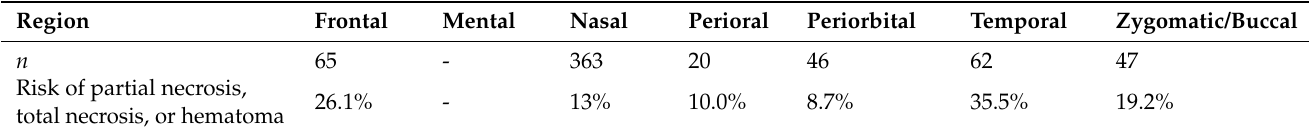
Table 6. Partial necrosis, total necrosis, or hematoma by facial